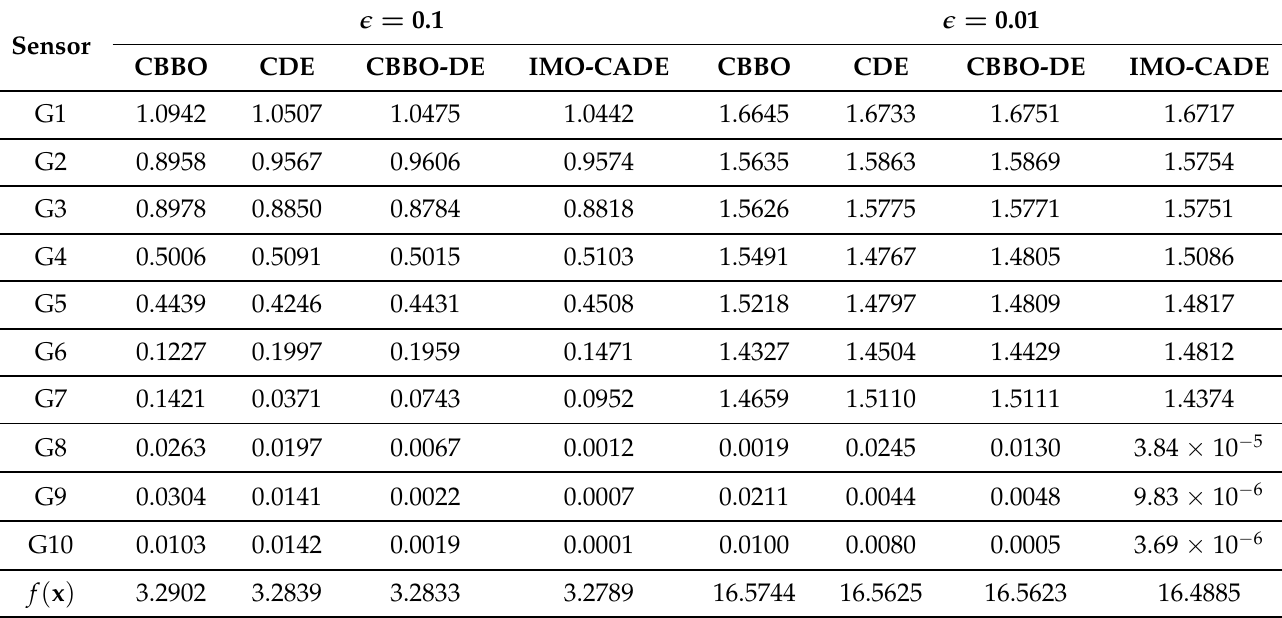
Table 8. Comparison of different numerical methods to gain allocation with K = 10, γ 0 = 10 dB, and ρ = 0.1. (cid:101) = 0.1 (cid:101) = Sensor